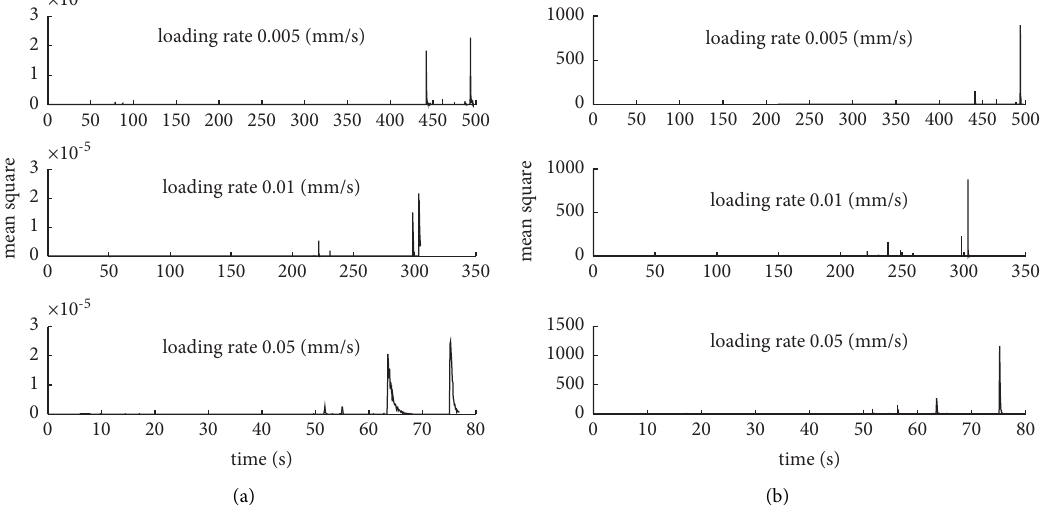
Figure 11: Mean square energy of microseismic and charge signals of sandstones at different loading rates. (a) Microseismic. (b) Charge